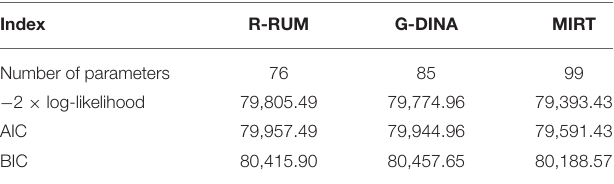
TABLE 3 | Summary of goodness-of-fit statistics of the three